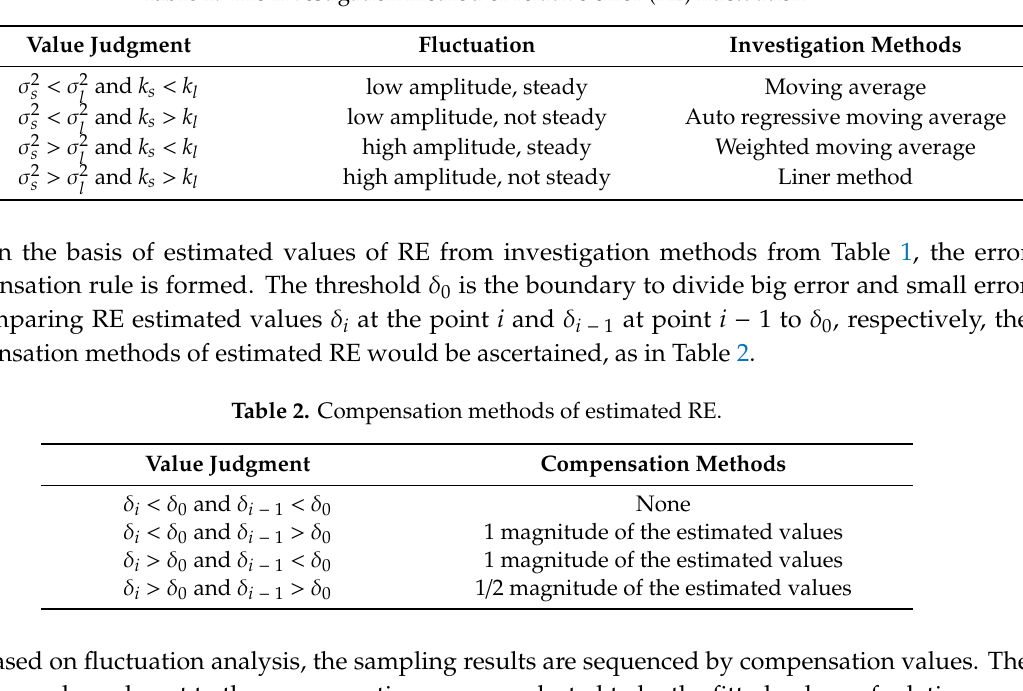
Table 1. The investigation method of relative error (RE) fluctuation.